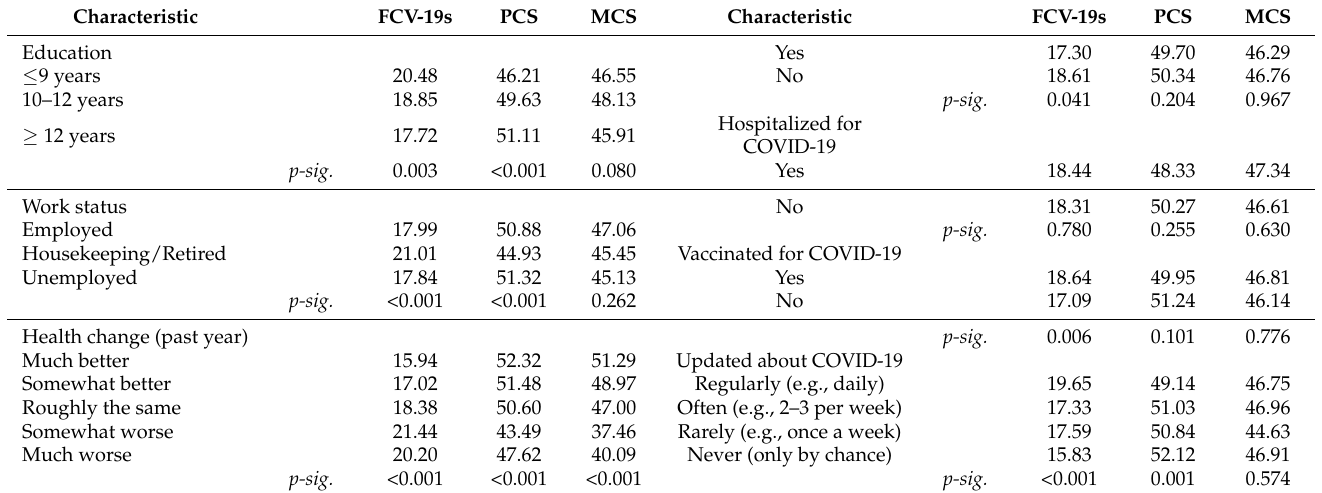
Figure 2. Distribution of FCV-19s responses by past Coronavirus infection (Yes/No). The results of the multivariate analysis with Gamma regression, which was used to model the PCS and MCS scores, are presented in Table 5. Higher fear of COVID-19, in- creasing age, having at least one comorbidity and previously hospitalized for this comorbid condition, female gender, being divorced or widowed and past year self-reported decreasing health were negatively associated with physical health. Fear of COVID-19 and age were the two strongest predictors of physical health. The results were quite similar in the MCS model, with the most noteworthy difference being the positive association between age and mental health. The goodness of fit of the gamma regressions was assessed by examining the devi- ance residuals for both models. For the PCS-12 model, deviance residuals were between − 0.494 and 0.344, with a median of 0.020, and fi rst and third quartile values of − 0.075, and 0.087, respectively. For the MCS-12 model, deviance residuals were between − 0.922 and 0.569, with a median of 0.018, and fi rst and third quartile values were − 0.096 and 0.123, respectively. For both models, the QQ plots and residual diagnostics graphs were within acceptable limits (results not shown for parsimony).